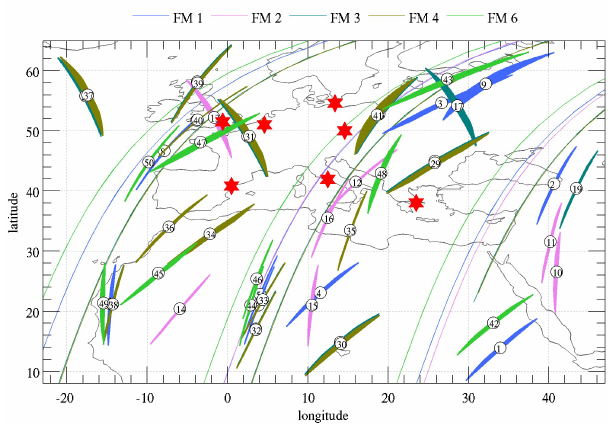
Figure 8. Longitude and latitude distributions of the E s Occur- rence Area (EOA) of 50 RO events observed by COSMIC during 2006.294, 11:00–15:00UT over and surrounding Europe region. The circle on each EOA is the corresponding tangent point at an altitude of 100km with the case serial number embedded. The light lines are the orbits of COSMIC LEO satellites during this time in- terval. Different colors represent different COSMIC FM satellites. The red stars show the location of seven ionosondes